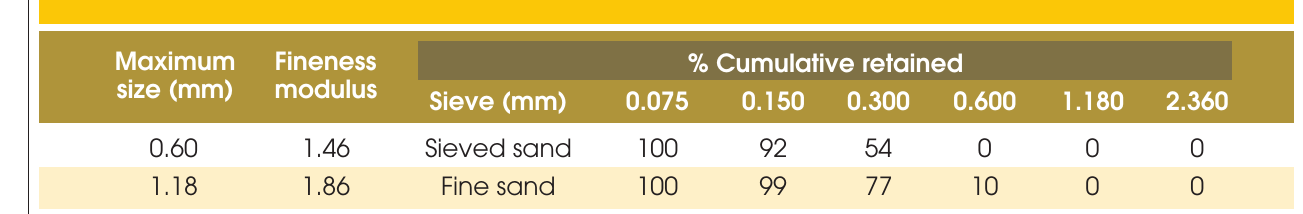
Table 2 – Size distribution of sand used (sieved and fine